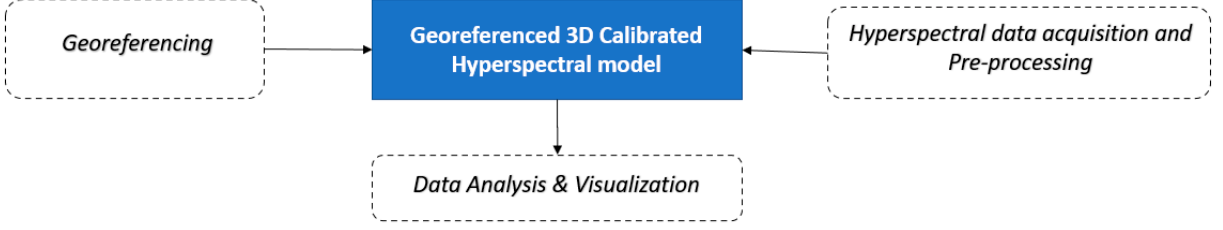
Figure 3. Overall workflow.